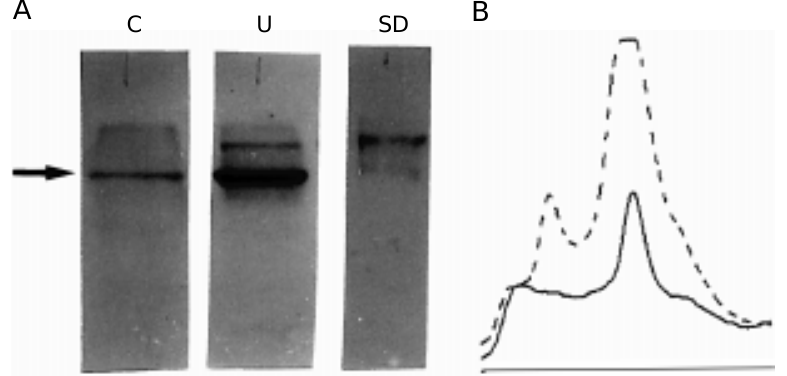
Figure 3 - Western blot reaction against laminin. These data were obtained as in the previous figure, blotting the membrane with anti-laminin antibodies (A). Lanes U and C were loaded with 45 µg of protein extracted from ECM bone marrow (undernourished and control group, respectively) and lane SD was loaded with 1 µg of commercial laminin, used as standard. Densitometric measurement was performed (B) and the differences in band areas are shown. The solid line refers to the control sample and the dashed line refers to the undernourished mouse sample. A similar profile was obtained in three different experi- ments done with the same ECM pool (control and undernourished). We tested two different groups of control and undernourished mice with similar